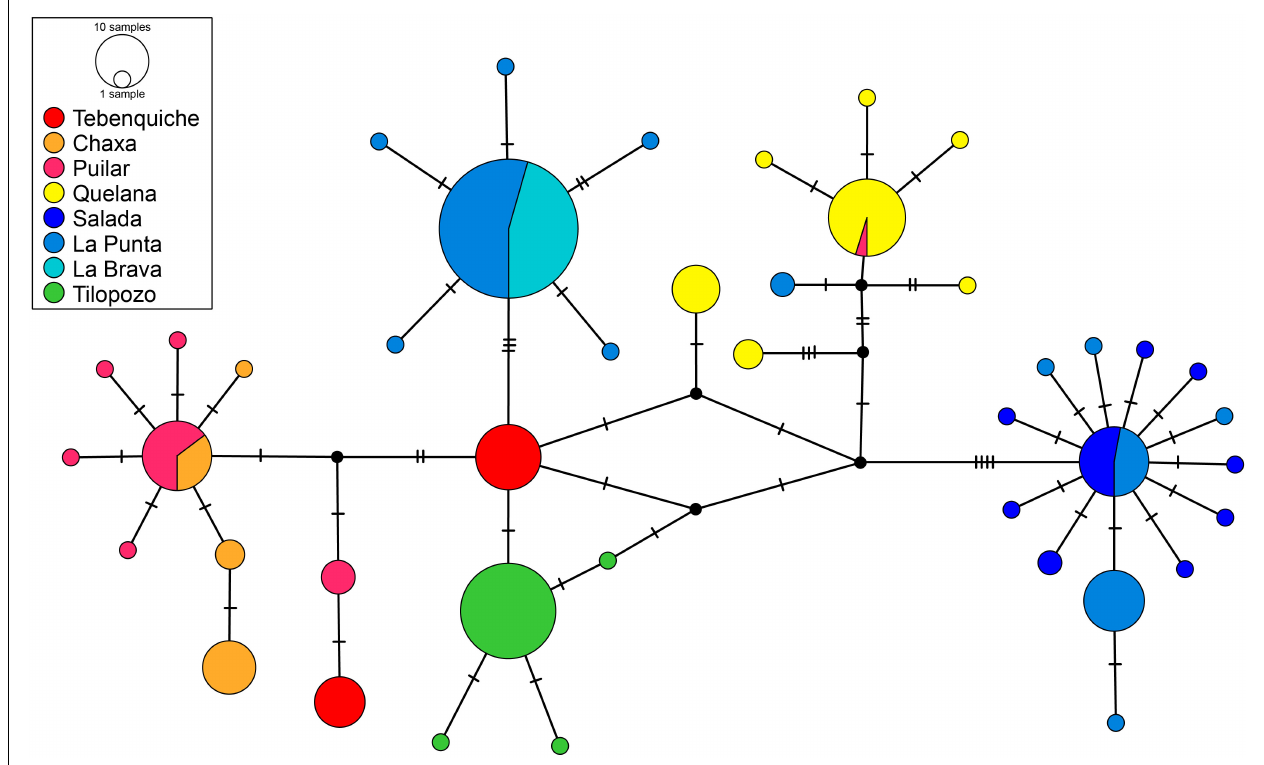
FIGURE 3 | Haplotype network of Heleobia populations of the Atacama Saltpan obtained from partial sequences of the COI gene. The segments on the lines represent the number of mutational steps. Circle sizes are proportional to haplotype frequencies and colors represent the respective sample